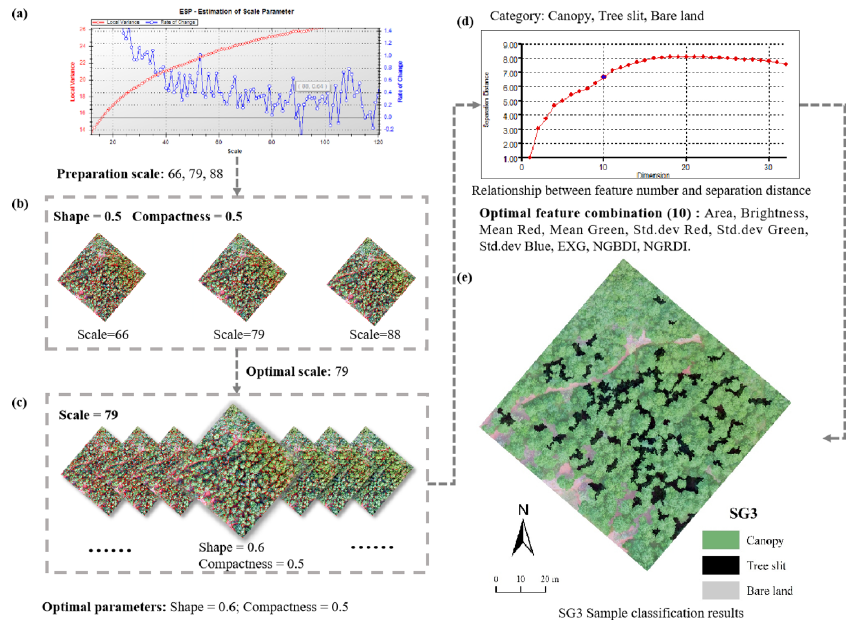
Figure A5. The process of extracting the canopy of sample SG3 based on an object-oriented method. ( a ) The preparation scales were calculated using the ESP2 tool and obtained as 66, 79, 88; ( b ) The shape and compactness parameters were both set to 0.5 for comparison to obtain the optimal segmentation scale of 55; ( c ) The shape and compactness parameters are 0.6/0.5 when iterating through the shape and compactness parameters to obtain the best segmentation effect, respectively; ( d ) Ac- cording to the relationship between feature number and separation distance choose to the optimal feature combination; ( e ) SG3 Sample classification results.